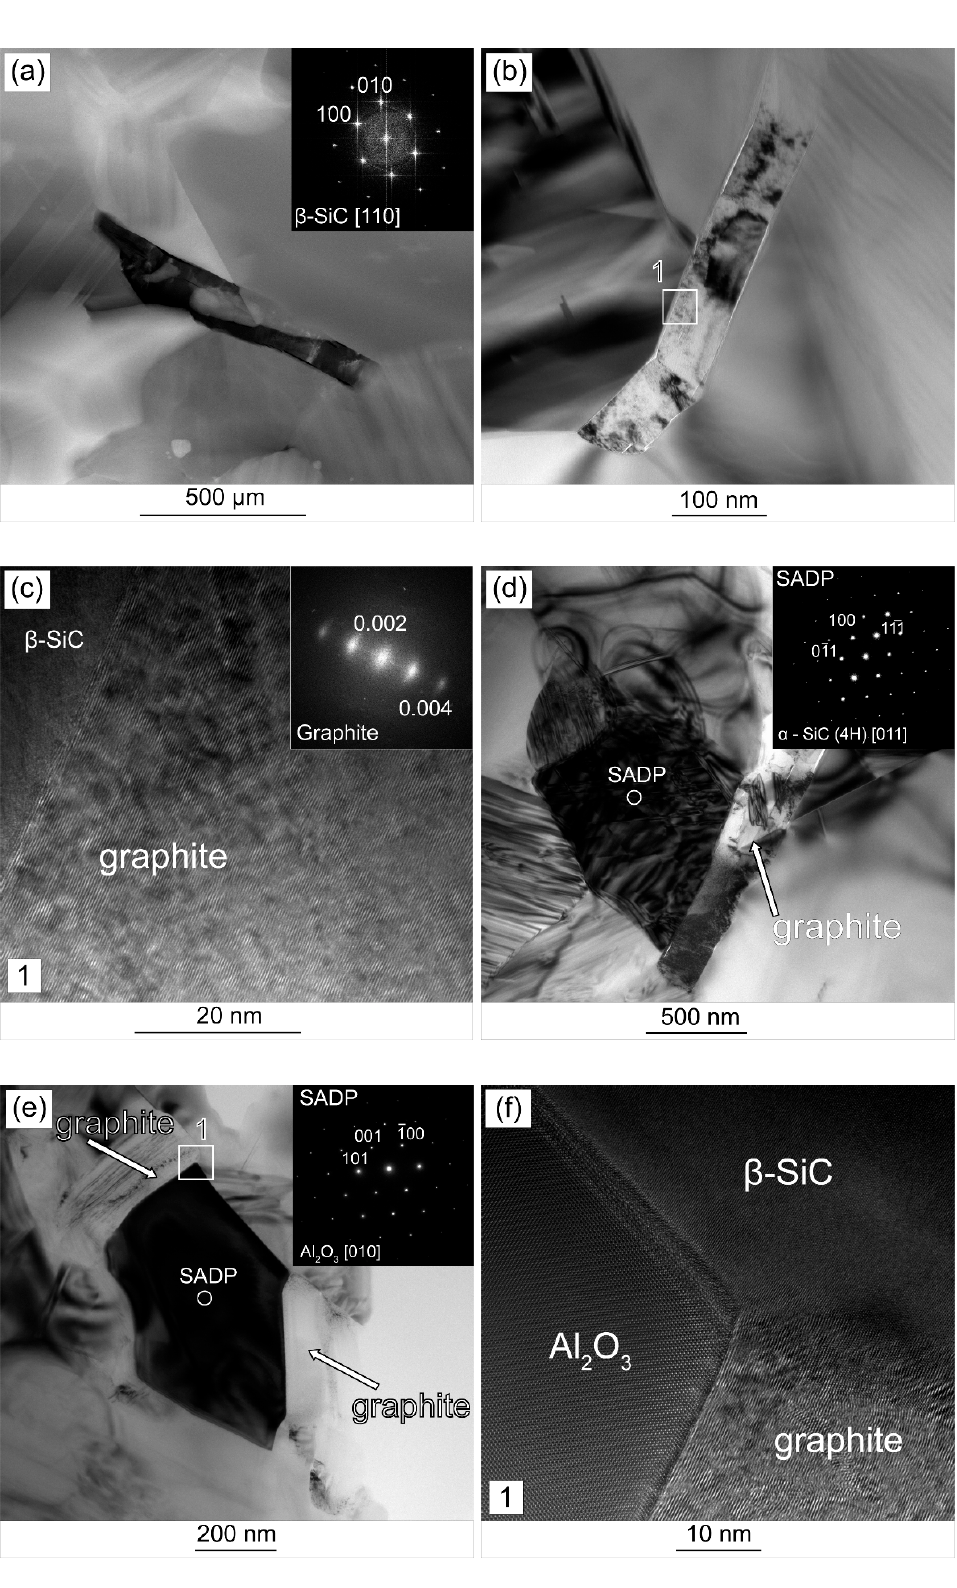
Figure 7. TEM analysis of SiC-2 wt.% Ti 3 C 2 T x M composites ( a ) HAADF STEM image of reinforcing phase and electron diffraction; ( b ) TEM BF image of the reinforcing phase; ( c ) HRTEM image of area 1 and the Fourier transform; ( d ) TEM BF image of the composites and selected area diffraction pattern (SADP); ( e ) TEM BF image of graphite structures surrounding the Al 2 O 3 grain; ( f ) HRTEM image of the interface boundary between graphite, SiC and Al 2 O 3